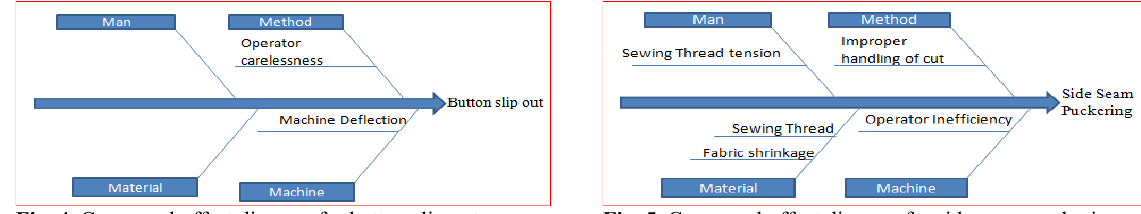
Fig. 3. Cause-and-effect diagram for sleeve hemming